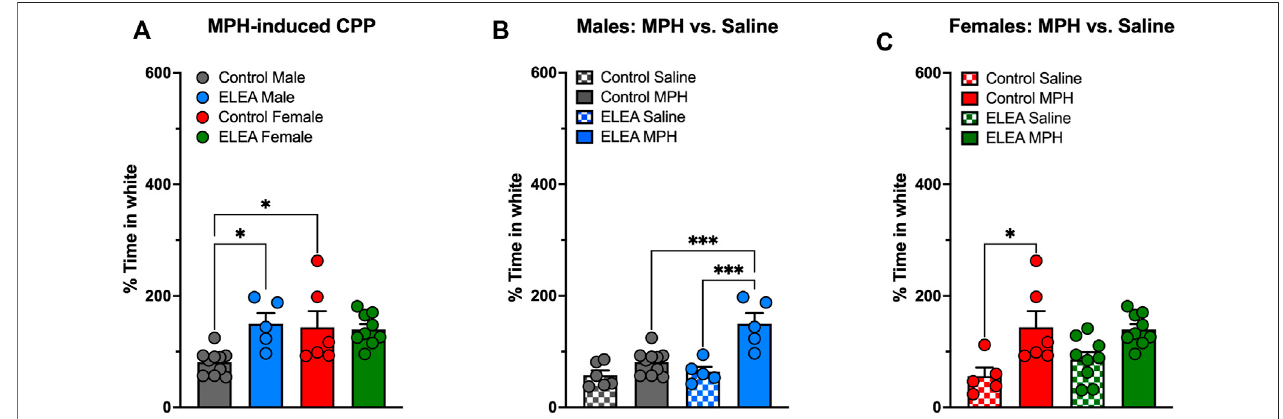
FIGURE 2 | Methylphenidate preference of adult male and female rats exposed to antibiotics during early life. ELEA increased time spent in white compartment (associated with drug delivery) only in males and not females (A – C) after a 5-days conditioning period to MPH. Also, control females spent more time in the MPH- associatedcompartmentthancontrolmales (A) .ELEAmalesspentmoretimeinthewhitecompartmentwhenpairedwithdrugdeliverycomparedtosalineinjectionand MPHinjectionincontrolanimals (B) .Conversely,onlycontrolfemalesspentmoretimeinthewhitecompartmentwhenpairedwithMPHdeliverycomparedtosaline injection, an effect not observed in ELEA females (C) (control male-saline, n = 6; control male-MPH, n = 10; ELEA male-saline, n = 5; ELEA male-MPH, n = 5; control female-saline, n = 5; control female-MPH, n = 6; ELEA female-saline, n = 9; ELEA female-MPH, n = 10; * = p < 0.05; *** = p < 0.001).